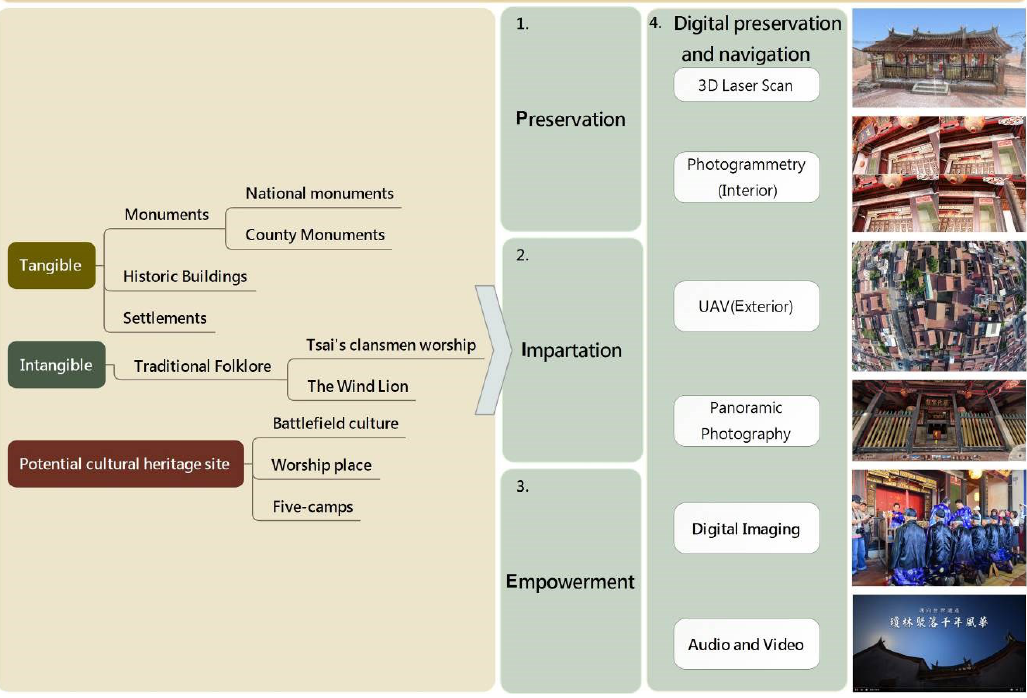
Figure 3. Digital contents associated with reconstruction of historical sites at the Chiung Lin Village